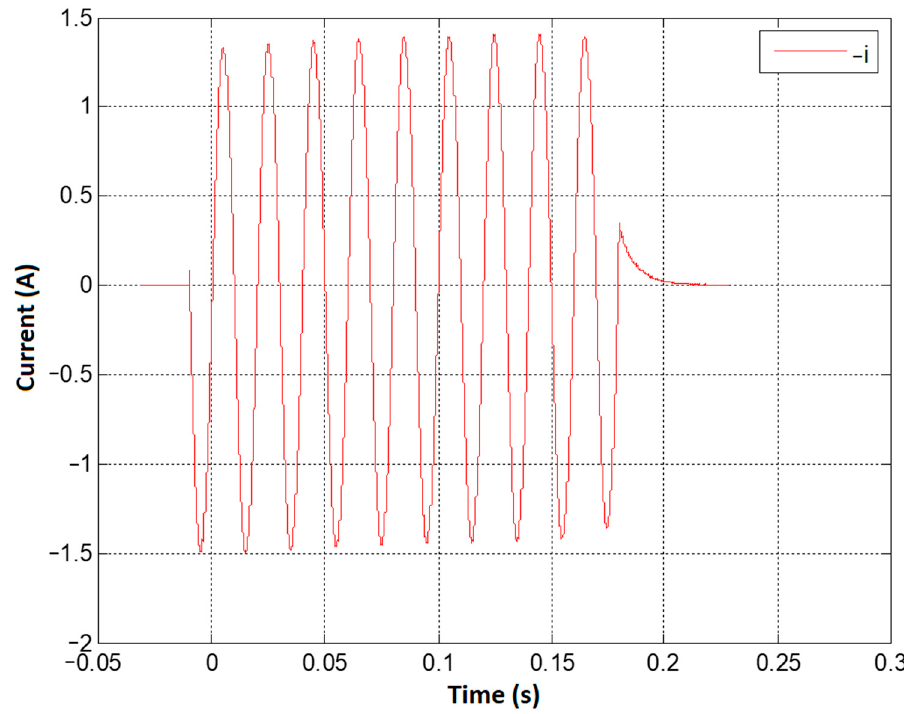
Figure 17. The waveform of the current for which the test was executed. RMS current value—6400 A.